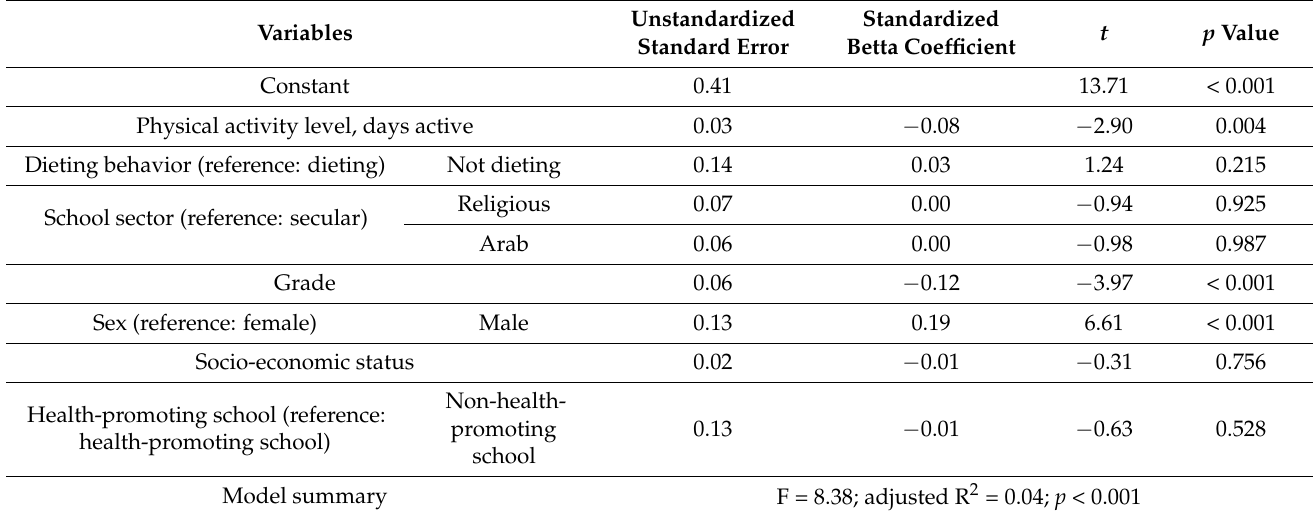
Table 5. Summary of multiple regression analysis: screen